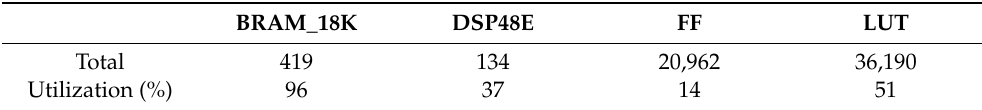
Table 1. LeNet-3.3 IP core resource usage